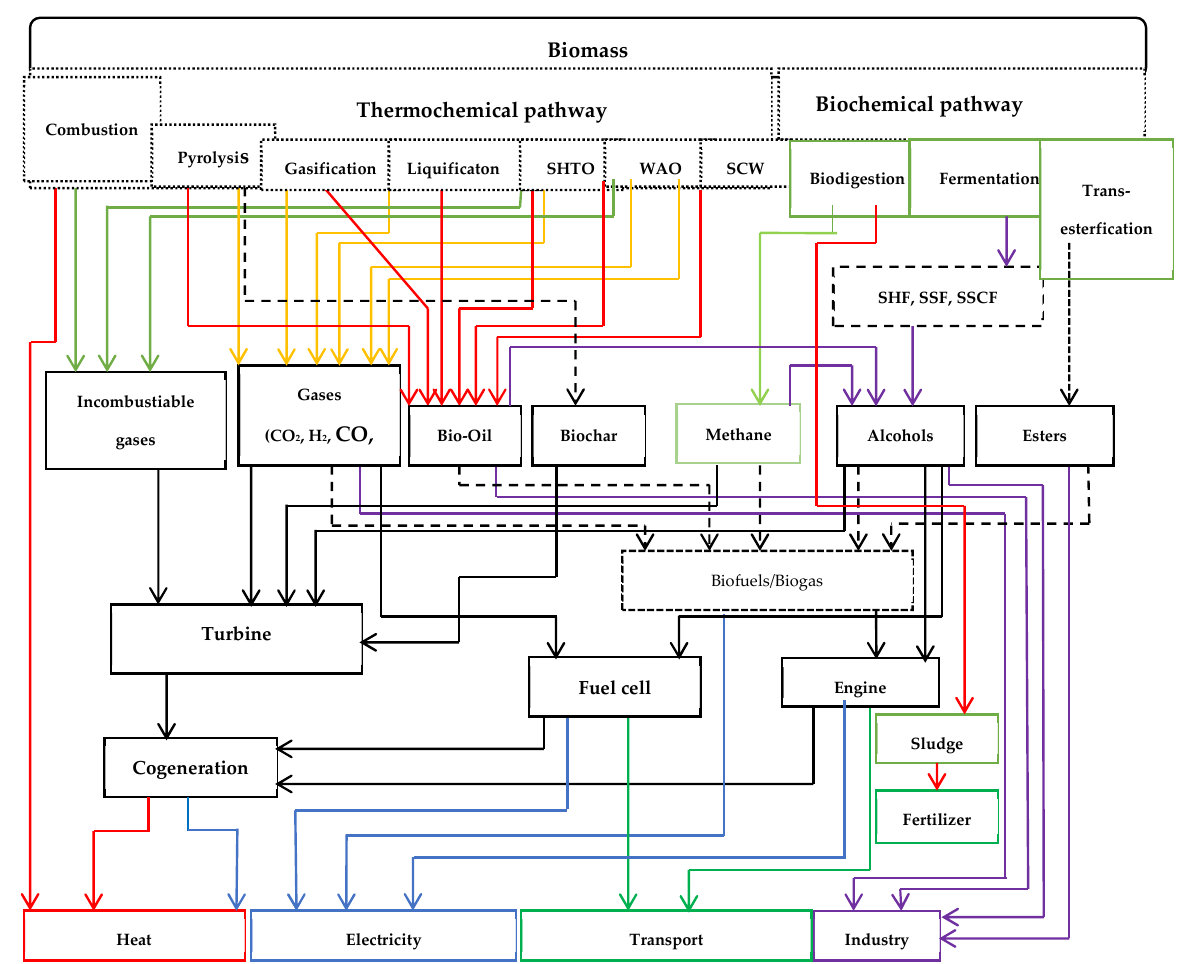
Figure 2. Main integrated biomass-to-biofuel conversion processes and technology affiliation for final products uses, adapted by [35].